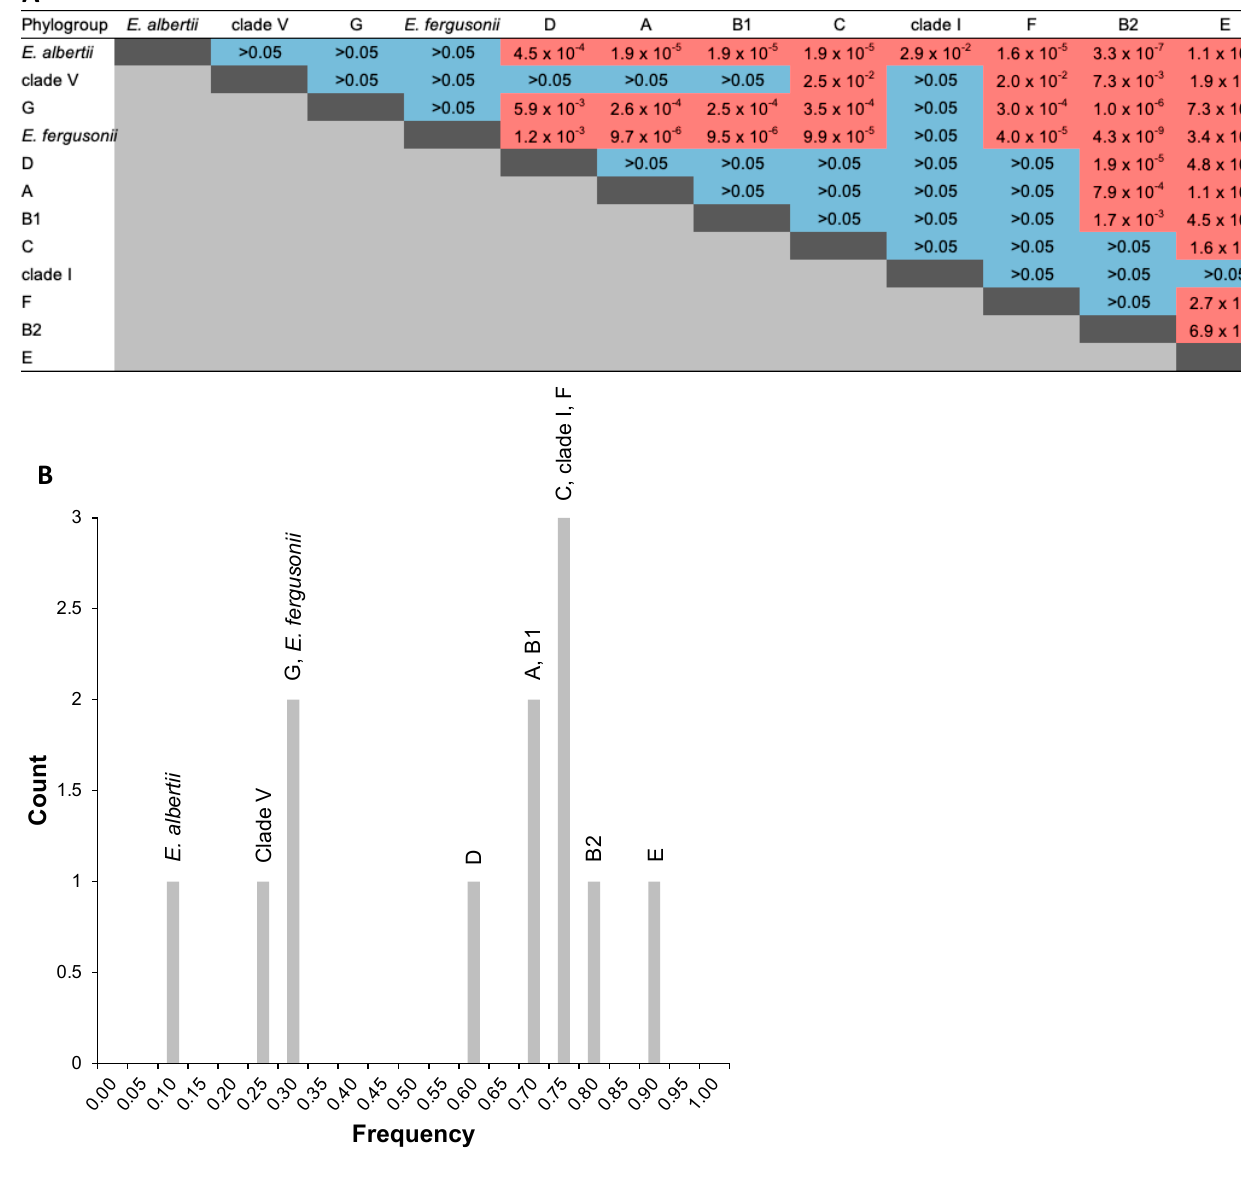
Figure 11. Statistical analyses of the relationships between the Escherichia phylogroups respective to presence or absence of agn43 . ( A ) Table of the pairwise independence Fisher tests respective to the Escherichia phylogroups and the presence or absence of agn43 in genomes. Pairwise independence ( p -value > 0.05) or absence of independence ( p -value < 0.05) are highlighted in blue and red, respectively. ( B ) Plot of the frequency count for the presence of agn43 respective to the Escherichia phylogroups. Details of statistical analyses are available in supplementary Table S1.